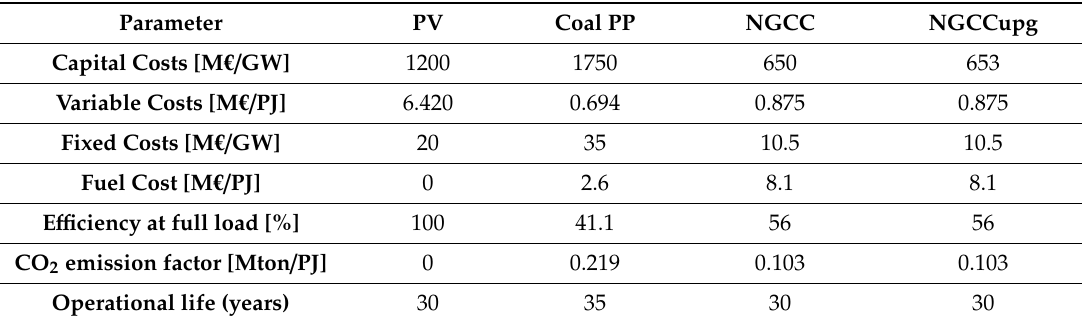
Table 2. Main techno-economic assumptions of the case study.